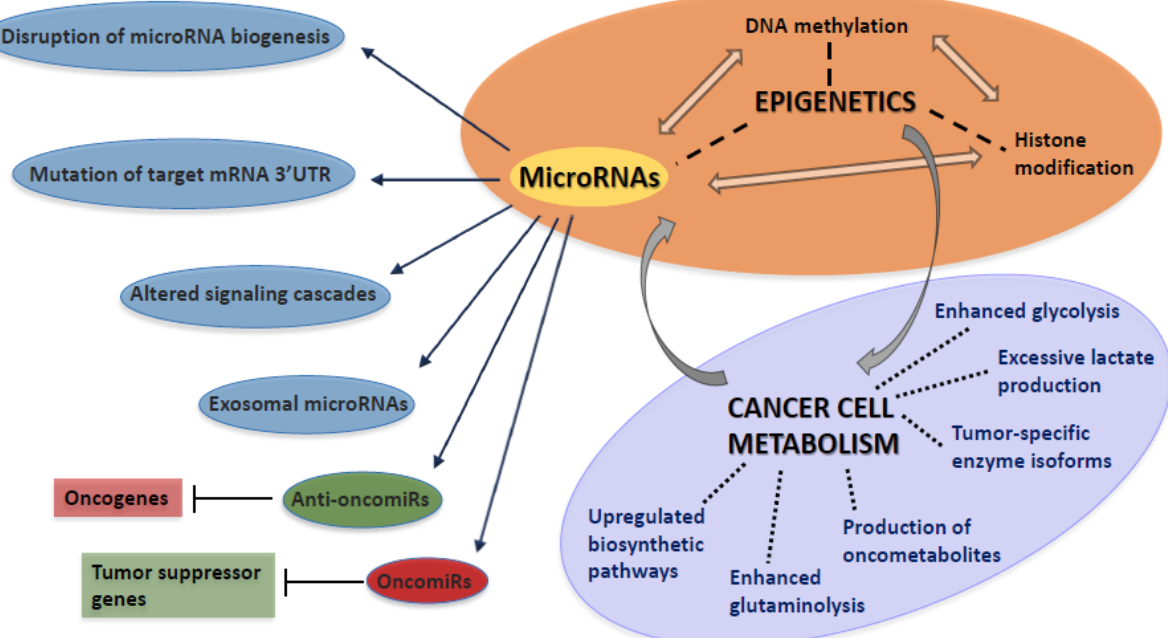
Figure 1. MicroRNAs contribute to the initiation and progression of cancer by a wide variety of different mechanisms, including multiple interactions with oncogenes, tumor suppressor genes, DNA methylation and histone modification. Altered microRNA expression levels are also involved in the metabolic reprogramming of cancer cells. Targeting such Warburg-related microRNAs is a promising therapeutic approach. UTR: untranslated region.